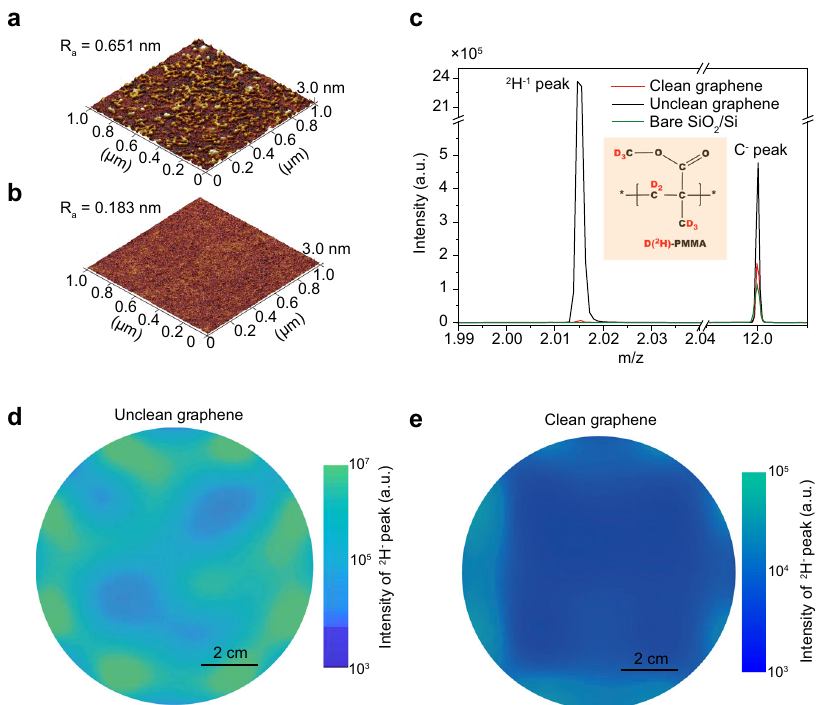
Fig. 2 The contamination-free transfer of large-area graphene fi lms. a , b atomic force microscopy (AFM) images of as-transferred graphene on SiO 2 /Si substrates by conventional PMMA-based techniques ( a ) and OVM-modi fi ed PMMA ( b ). R a : average roughness. c time-of- fl ight secondary ion mass spectroscopy (ToF-SIMS) spectra of as-transferred graphene on SiO 2 /Si substrates by conventional poly (methyl methacrylate) (PMMA)-based techniques (blue line), OVM-modi fi ed PMMA (red line), and bare substrate for reference (green line). Inset: structural formula of 2 H - PMMA. d , e 4-inch mapping of 2 H − peak intensities of as-transferred graphene on SiO 2 /Si substrates by conventional PMMA-based techniques ( d ) and OVM-modi fi ed PMMA ( e ). Note that graphene in ( b ) was transferred by cedrol (10 wt%)/PMMA and in ( c , e ) was transferred by alpha-terpineol (10